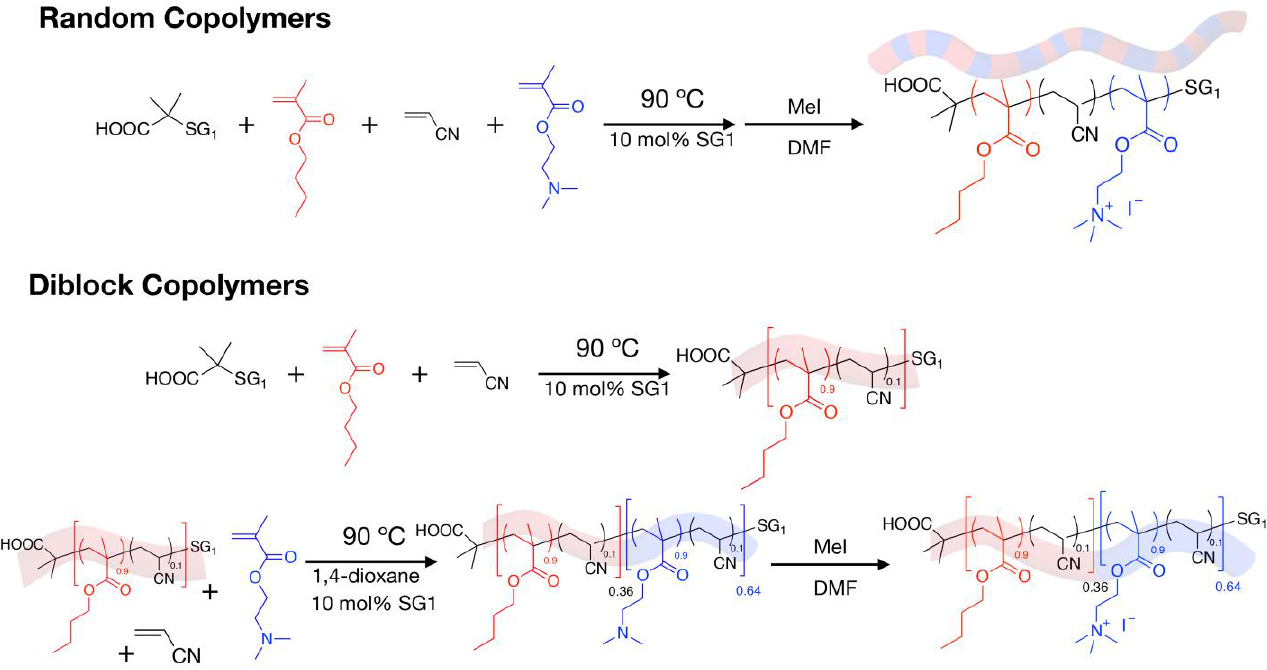
Figure 1. Synthetic routes and structures of Random and Diblock methacrylate-based copolymers. The synthesis of the copolymers detailed in the Materials and Methods section involves one (for Random) or two steps (for Diblock) synthesis. In all cases, the synthesis involves two monomers: butyl methacrylate (BMA, hydrophobic monomer, in red) and dimethylaminoethyl methacrylate (DMAEMA, hydrophilic monomer, in blue), and acrylonitrile (ACN), BlocBuilder (initiator), and SG1 (control agent) to initiate the polymerization. The permanent quaternization of the Random and Diblock copolymers (quaternary ammonium ion) is achieved by the methylation of the amine group in the presence of methyl iodide (MeI).